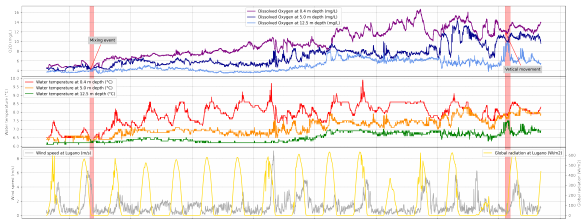
Figure 2: Data comparison between data collected by the Lugano